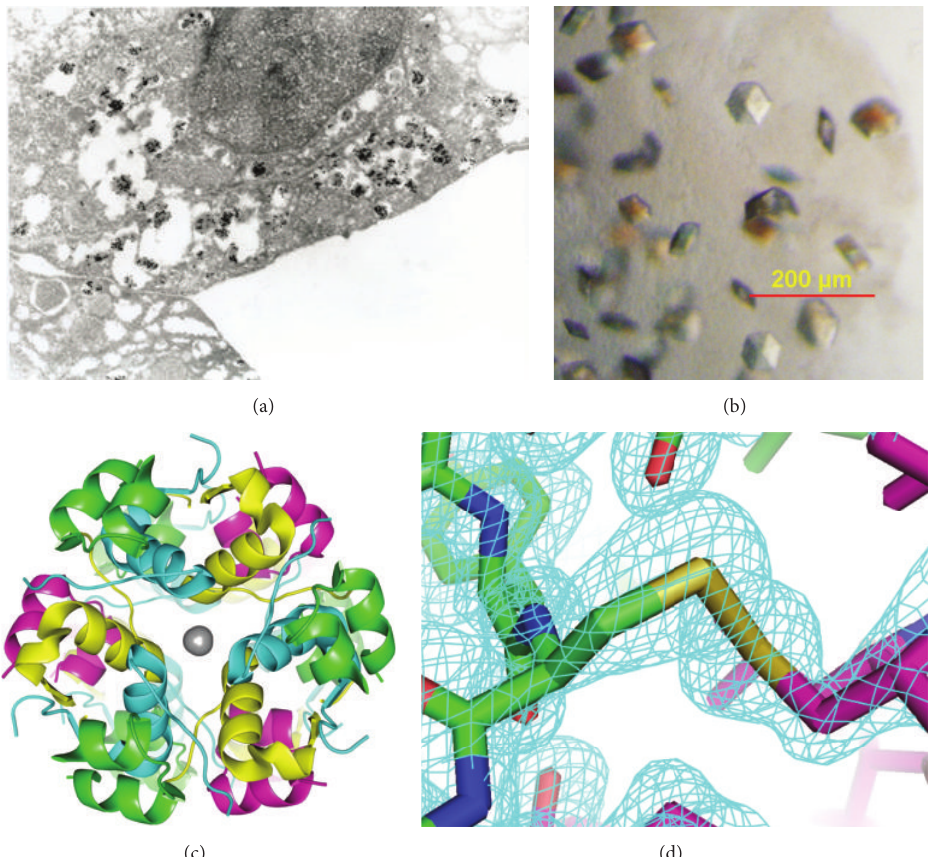
Figure 1: (a) Electron microscopy of a beta cell stained for sulfatide with colloidal gold granules as secondary indications. Close relationship to the insulin crystals is clearly seen. At the surface at the beta cells an insulin crystal close to exocytosis is clearly seen at one quartile from the right in the horizontal axis and half down in the vertical axis. (b) Upon crystallization, insulin formed hexamers of approximately 100 𝜇 m diameter. ((c) and (d)) Structure of insulin crystallized in the presence of sulfatide shows classic features of zinc bound insulin hexamers. (c) The crystals structure of insulin (PDB code 4XC4). Zinc is depicted as gray spheres. (d) An electron density map surrounding the disulfide bond linking cysteine chain A 20 to cysteine chain B